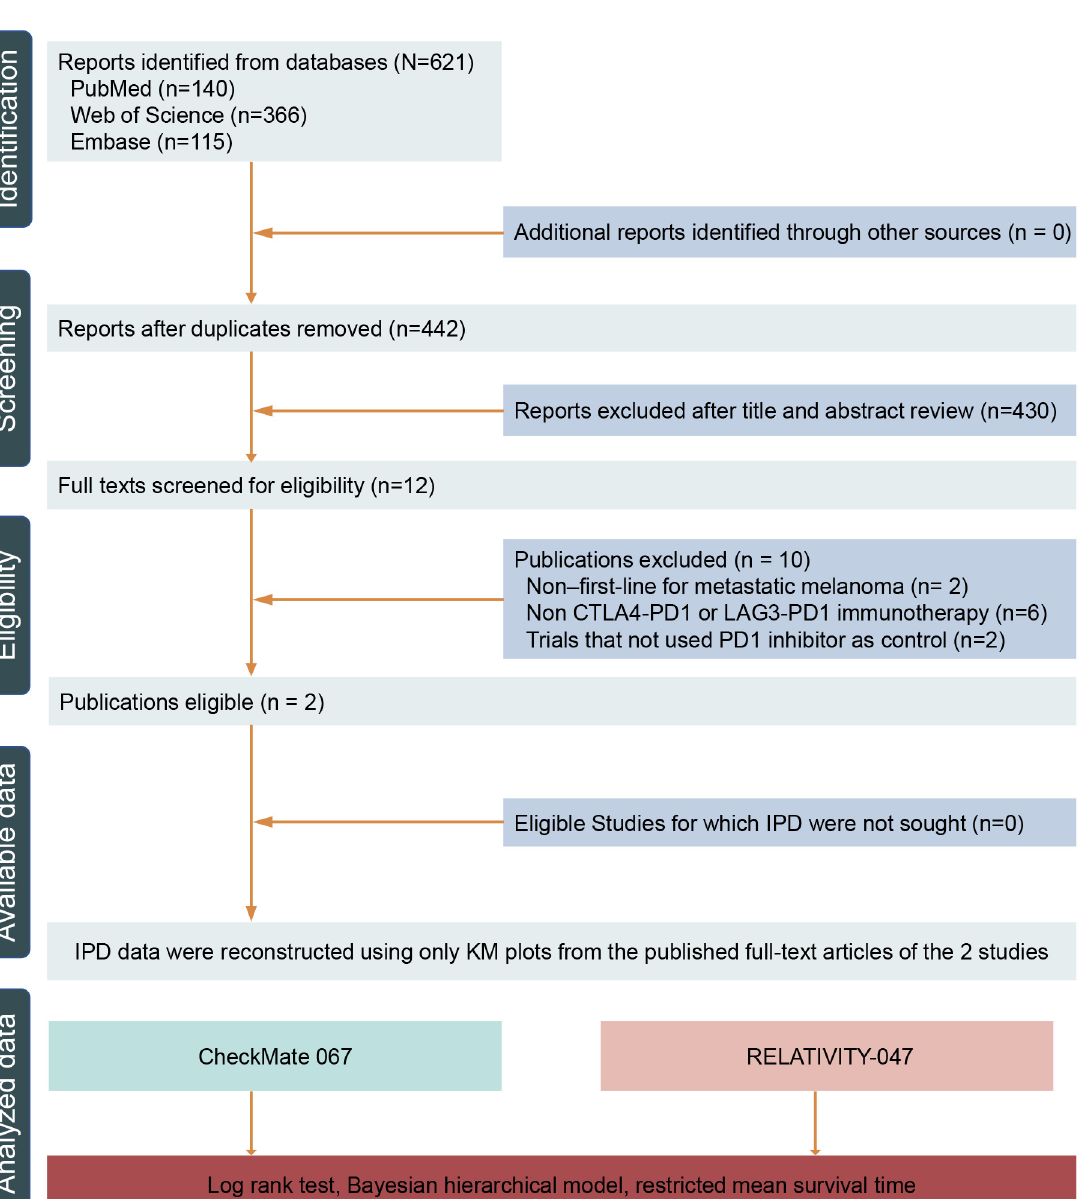
Figure 1. PRISMA flow chart for selecting eligible studies. Abbreviations: PD-1, programmed cell death 1; LAG3, Lymphocyte-activation gene 3; CTLA4, cytotoxic T-lymphocyte–associated antigen 4; IPD, individual patient data; KM, Kaplan–Meier. Table 1. Study Information and Characteristic of Trials.